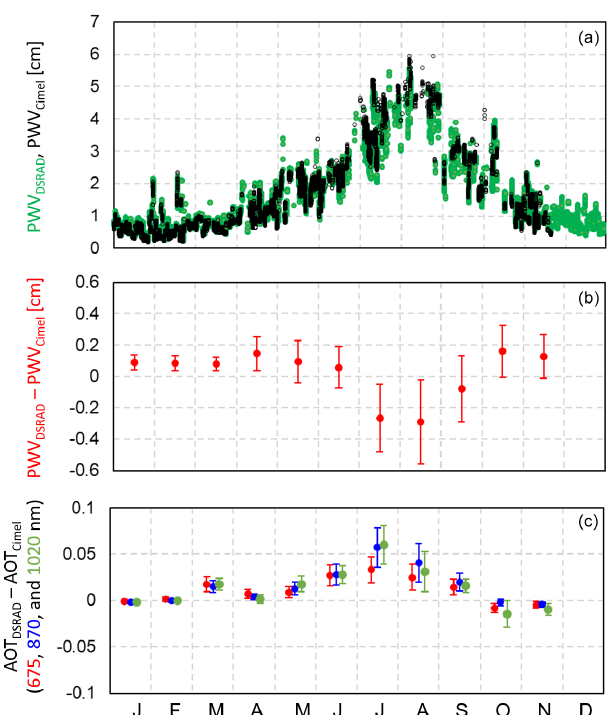
Figure 18. The top row shows the time series of PWV in 2017 at Chiba (green and black circles are PWV DSRAD + SKYMAP and PWV Cimel , respectively). The middle row is the difference be- tween PWV DSRAD + SKYMAP and PWV Cimel . The bottom row is the difference in aerosol optical thicknesses at 675nm (red), 870nm (blue), and 1020nm (green) between the DSRAD algorithm and the AERONET retrieval results. Circles and error bars in the middle and bottom rows are means and standard deviations,